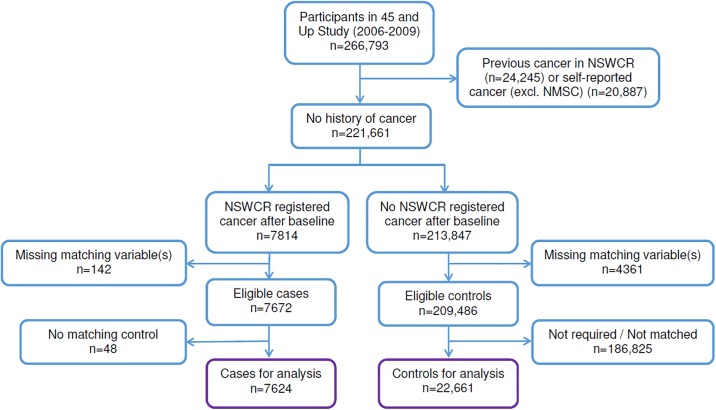
Cohort selection flow diagram.NMSC: Non-melanoma skin cancer; NSWCR: New South Wales Cancer Registry. Matching variables were age (±5 years), sex, Local Government Area of residence and smoking history (never or quit >15 years, recent quitter within 15 years, current smoker).